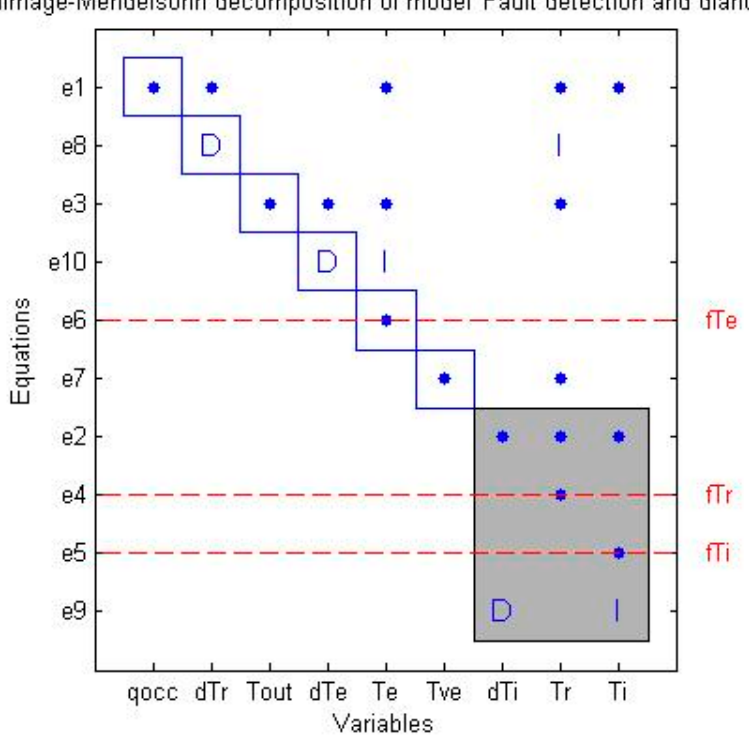
Figure 2. A Dulmage-Mendelsohn decomposition of scenario1 showing the faults location within the model.